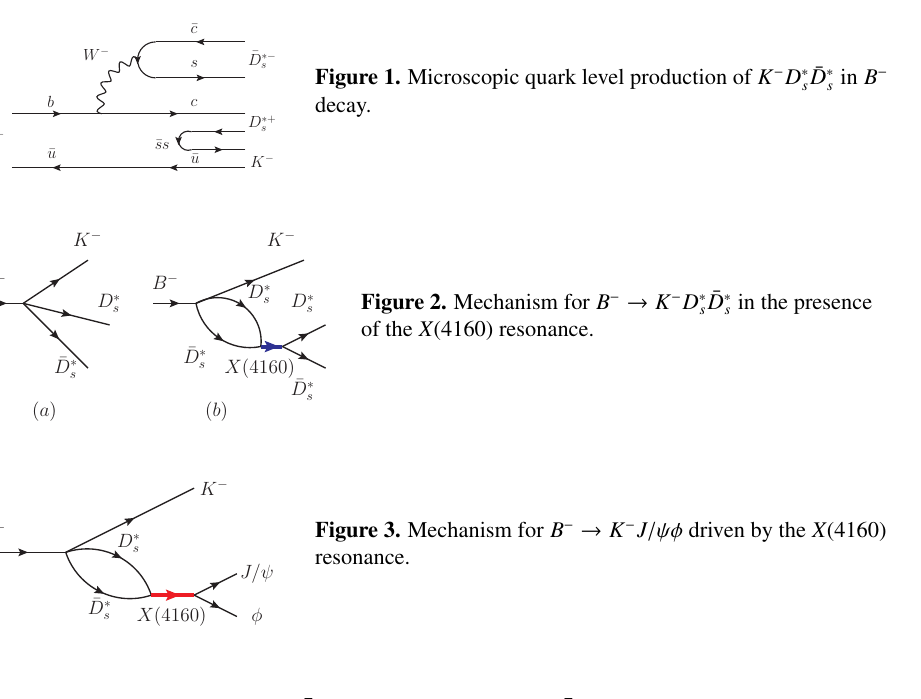
Figure 2. Mechanism for B − → K − D ∗ s ¯ D ∗ s in the presence of the X (4160) resonance.